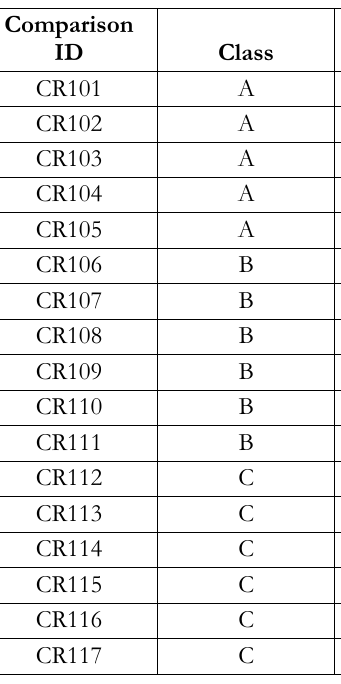
Table 4. Comparisons for Evaluating the Impact of Pair